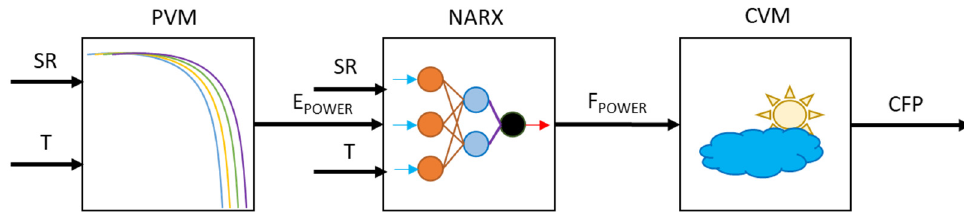
Figure 2. Flow diagram to carry out the electric power forecasting of a photovoltaic system.